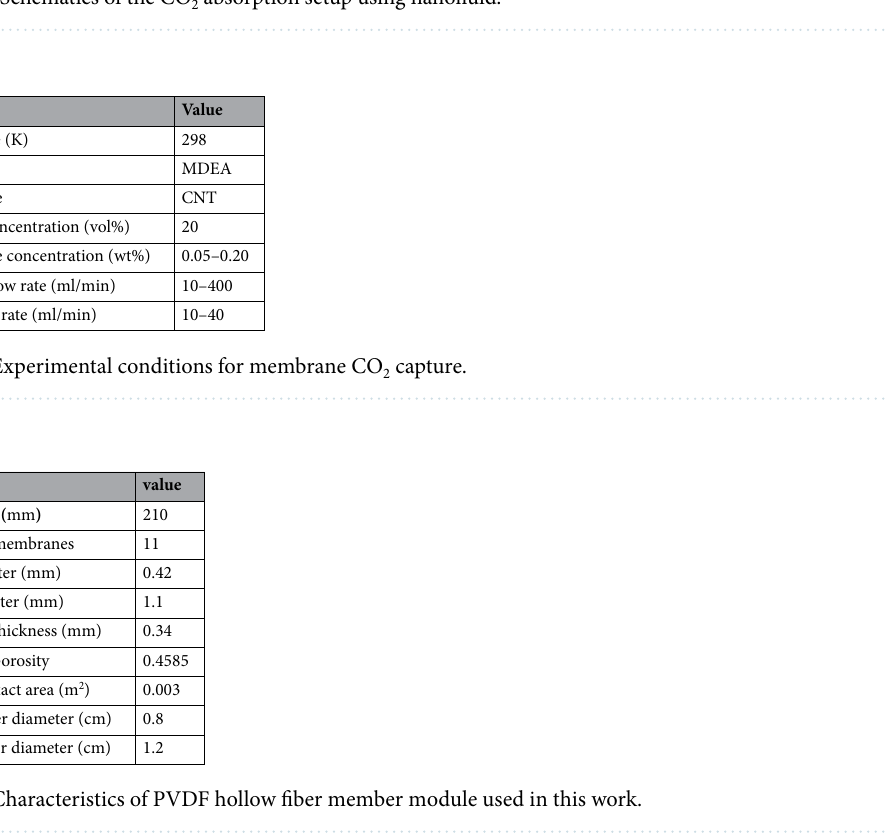
Figure 1. Schematics of the CO 2 absorption setup using nanofluid.